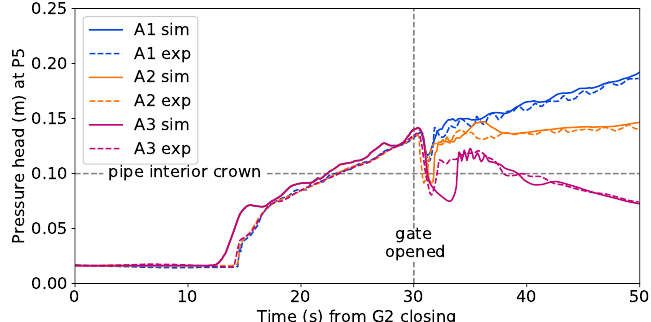
Figure 4. Pressure head at P5 for simulations and experiments of Cases A1–A3.